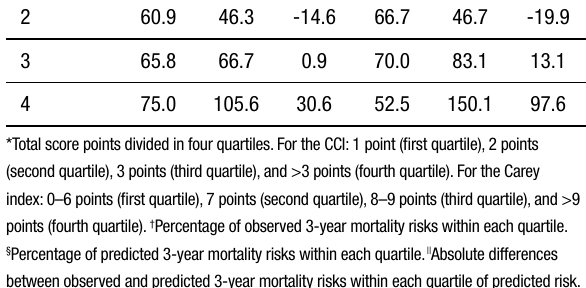
Table 2. Association of the Charlson comorbidity index and the Carey index with all-cause mortality (n=238). Index Charlson